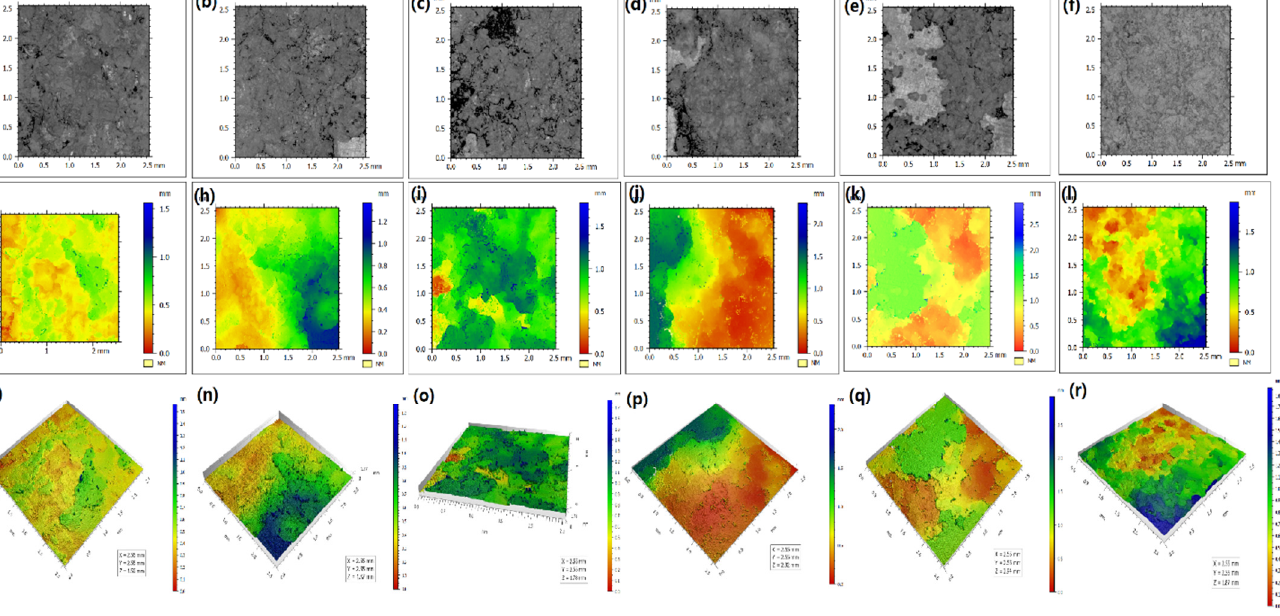
Figure 8. Observation of corrosion pits by laser confocal scanning microscope for six alloys. ( a – f ) Optical image of corrosion surface; ( g – l ) cross-section profile of the corrosion surface; ( m – r ) 3D structure of the corrosion surface.